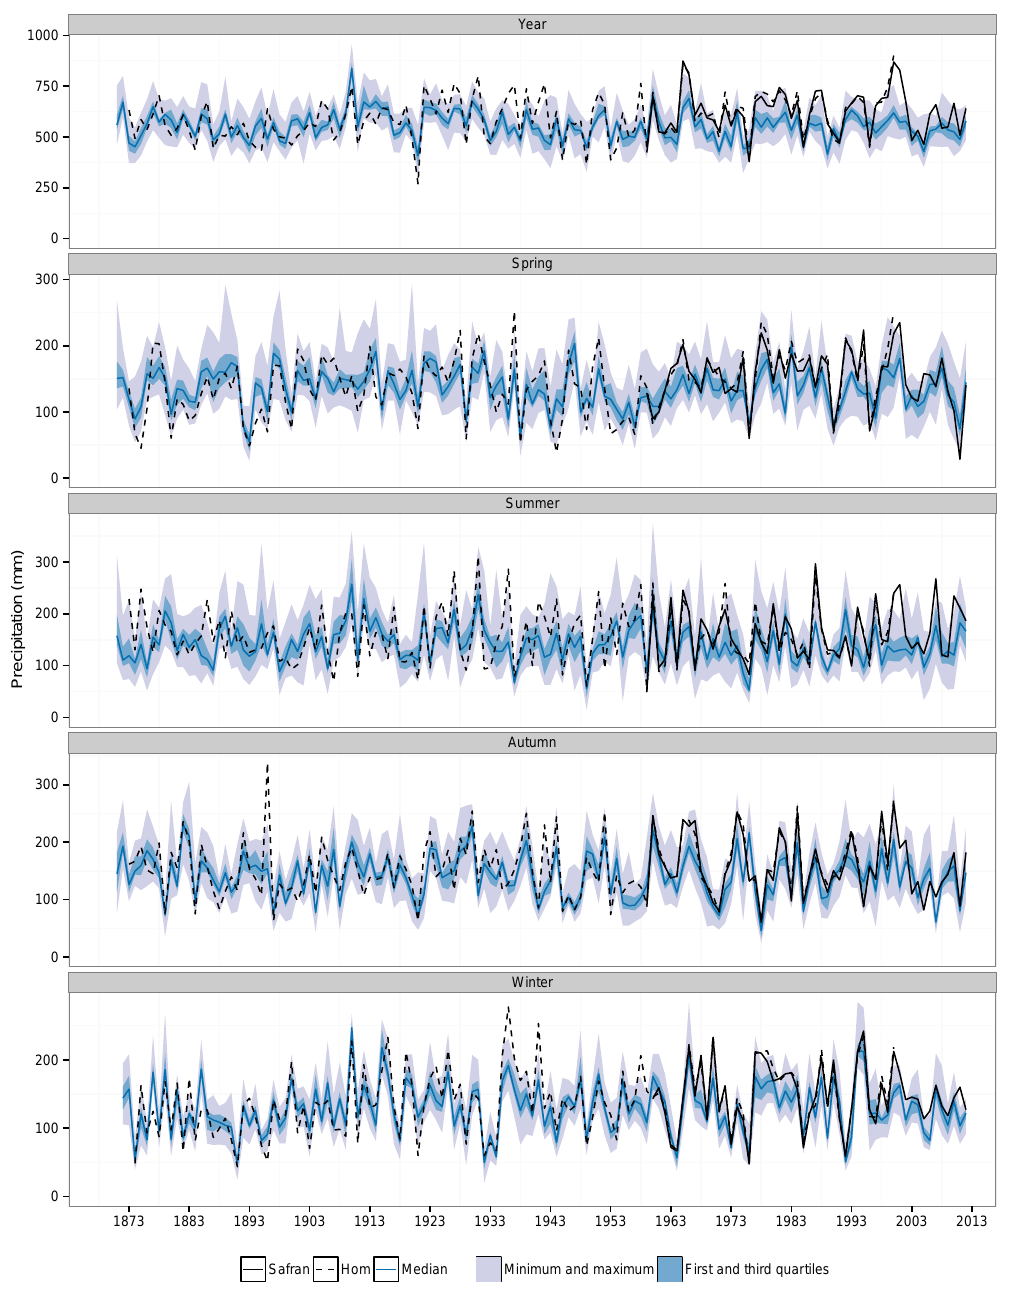
Figure 15. As for Fig. 14 but for